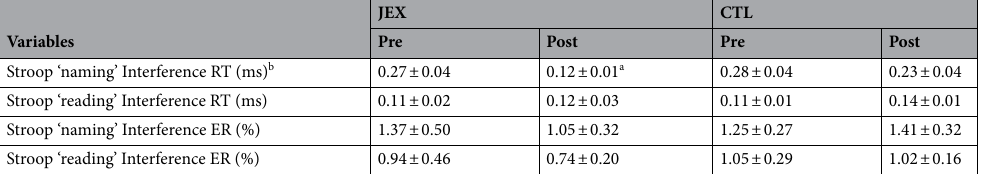
Table 2. The execution time and error rate for the Stroop ‘naming’ and ‘readings’ interference in response to 12 weeks of the judo exercise training program. Values are mean ± SEM. JEX judo exercising group, CTL control group, RT reaction time, ER error rate. a Significant differences from pre-JEX, p < 0.01. b Significant group (JEX/CTL) × time (PRE/POST) interaction, p < 0.05.